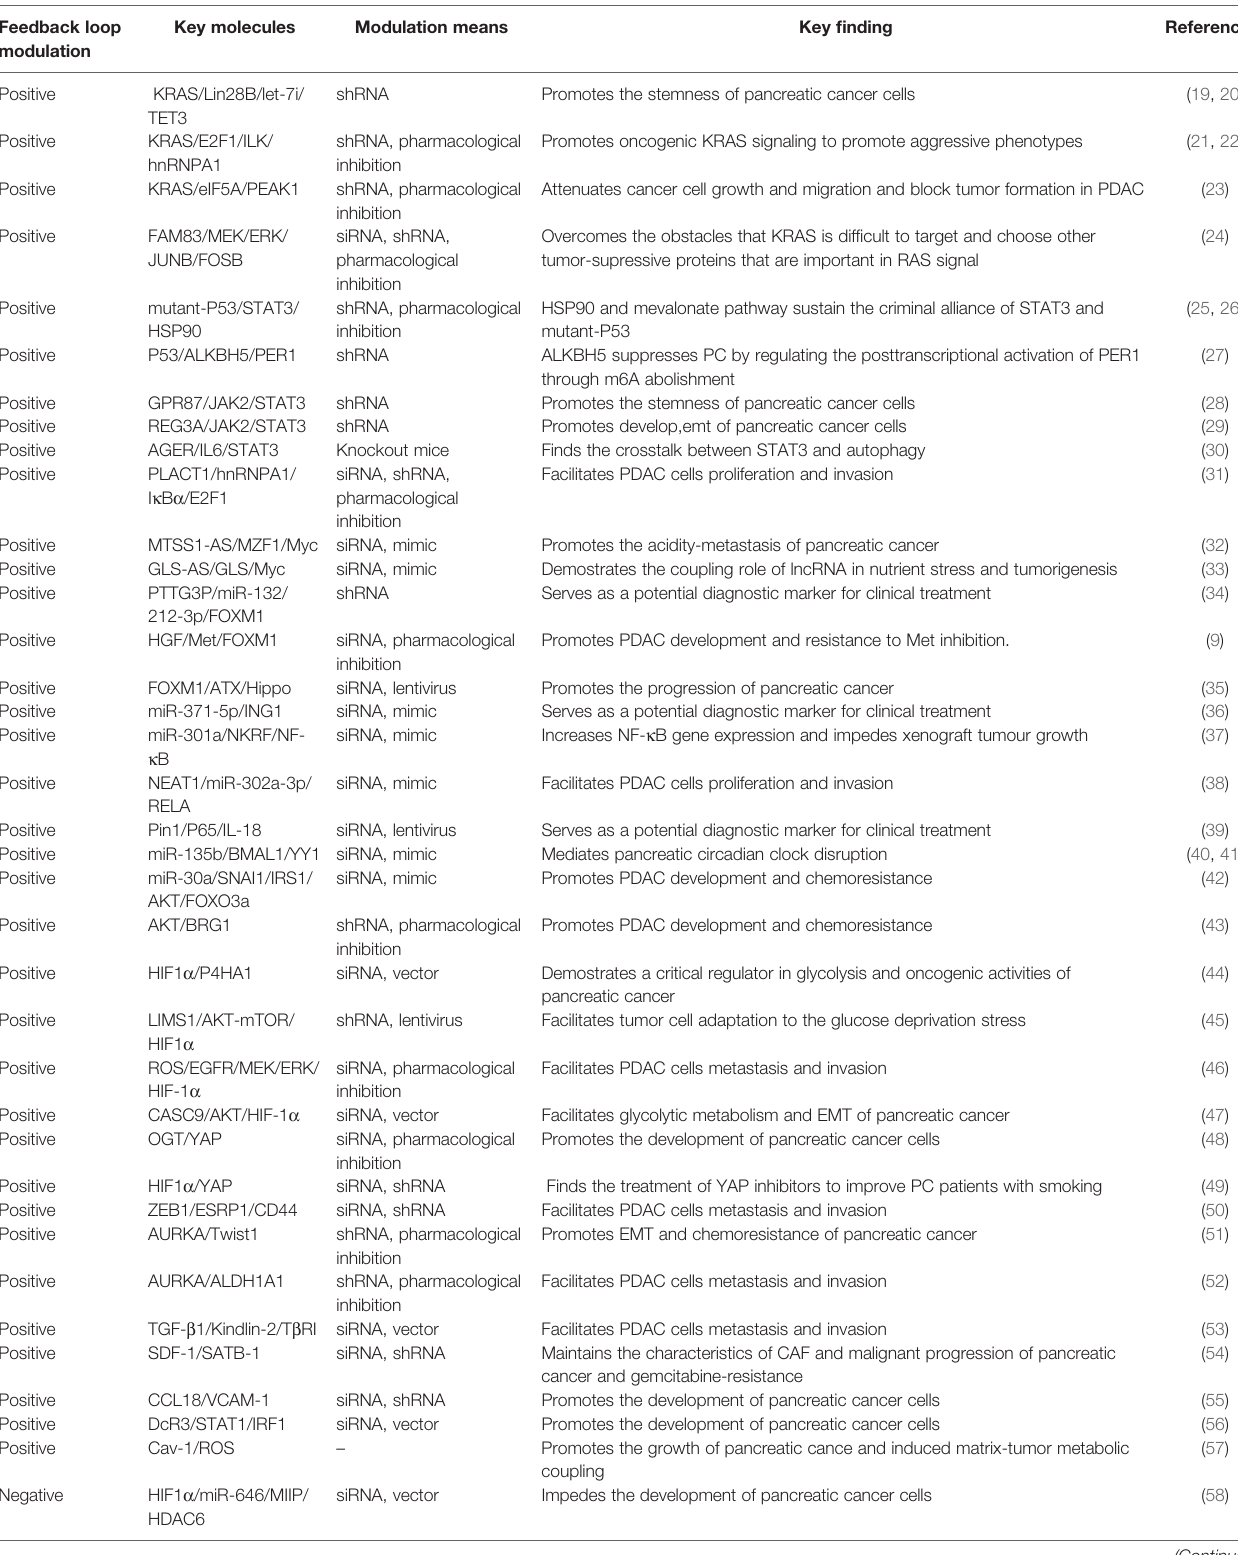
TABLE 1 | The role of different forms of feedback loop in pancreatic cancer. Feedback loop